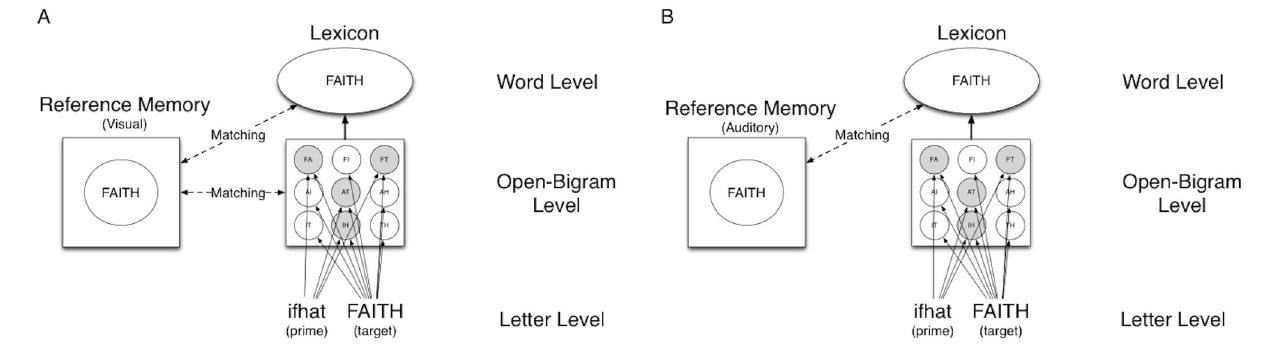
Figure 2. Model of the masked priming same-different task with visual (A) and auditory (B) reference stimuli and a scrambled prime. Gray-filled circles at the Open-Bigram Level indicate shared open-bigrams between prime and target.